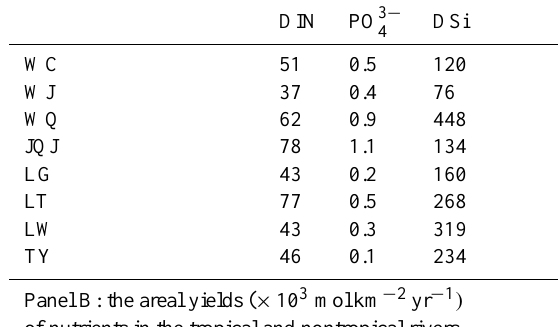
Panel B: the areal yields ( × 10 3 molkm − 2 yr − 1 ) of nutrients in the tropical and nontropical rivers DIN DSi PO 3 − 4 Large tropical rivers